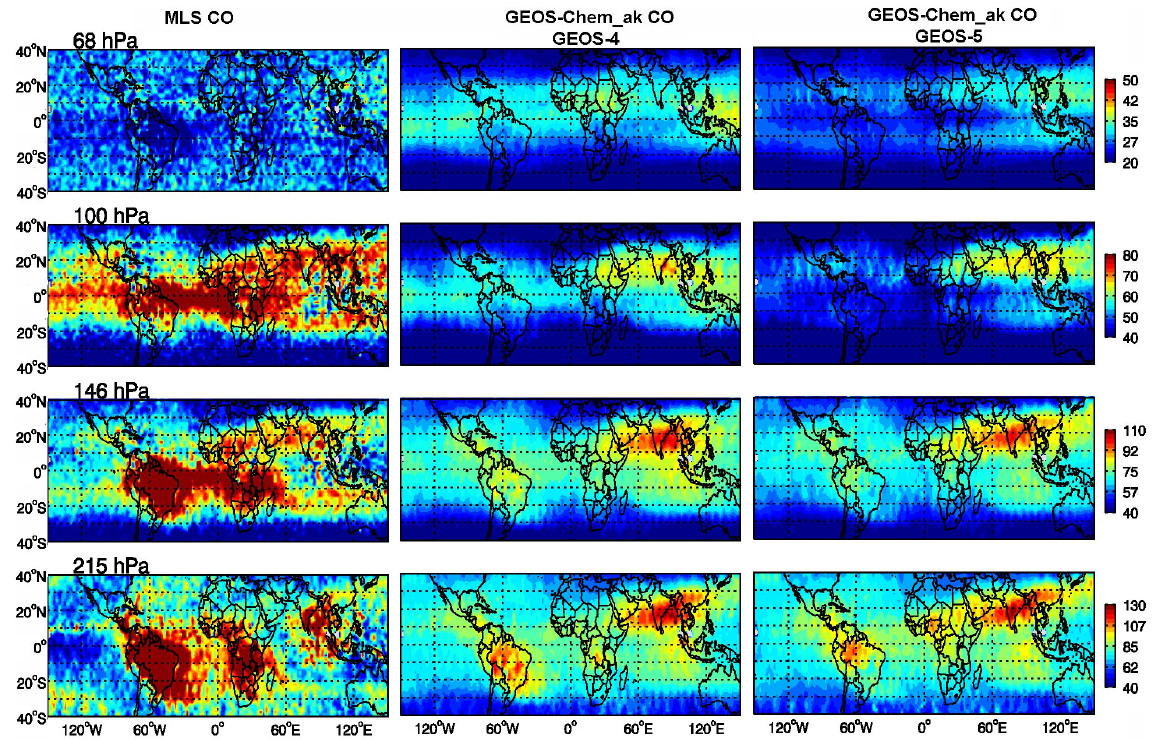
Fig. 6. Spatial patterns of monthly mean CO mixing ratios at 215hPa, 147hPa, 100hPa and 68hPa for October 2005 during the Southern Hemisphere biomass burning season from MLS (left), the GEOS-Chem simulations driven by GEOS-4 (middle) and GEOS-5 (right) with the MLS AKs